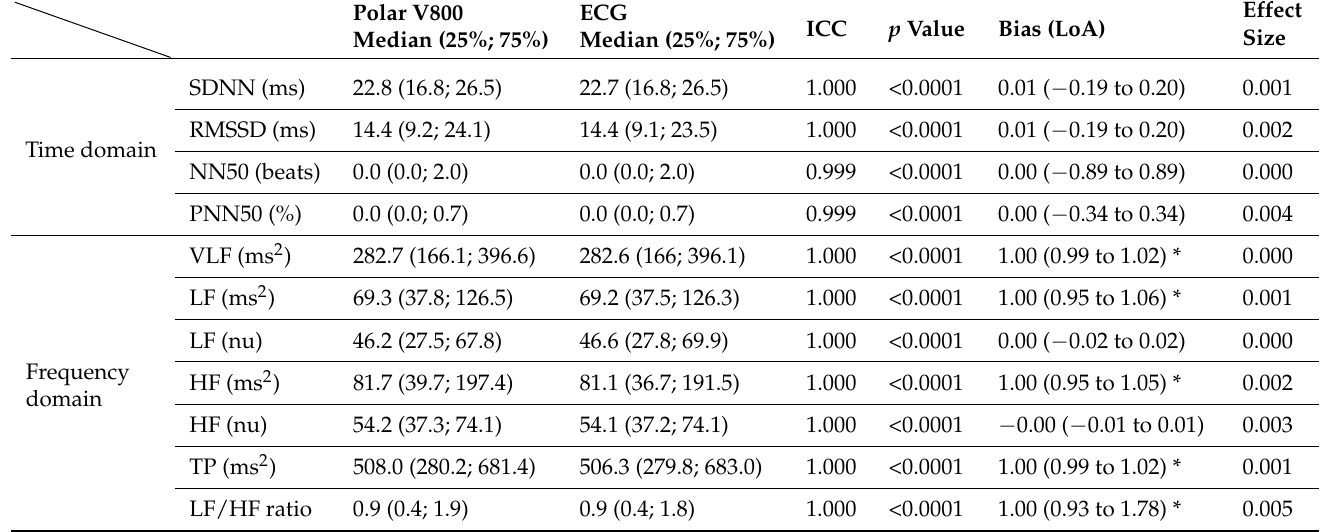
Table 3. HRV parameters for